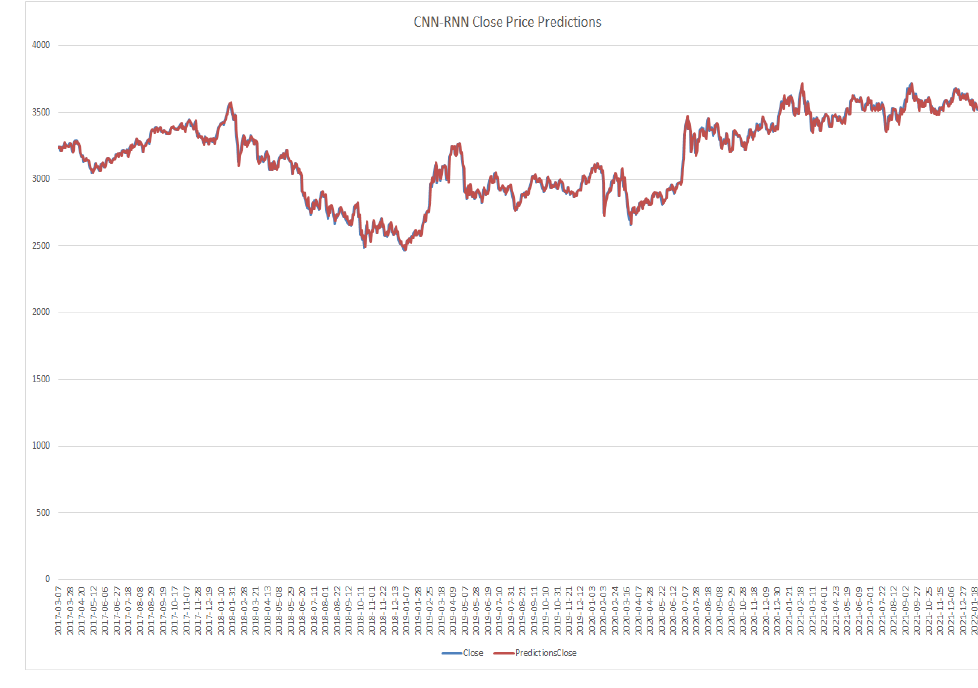
Figure 14. CNN-RNN model close price prediction.